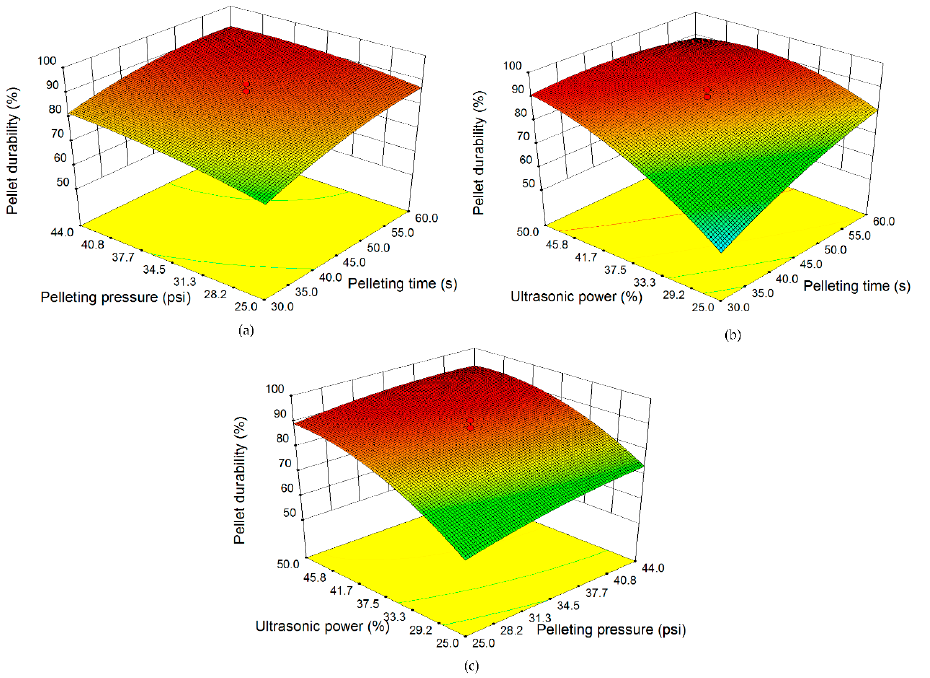
Figure 8. The interaction effects of pelleting time, pelleting pressure, and ultrasonic power on pellet durability. ( a ) The pellet durability in relation to pelleting time and pressure in a three-dimensional response surface. Pelleting pressure ranged from 25 psi to 44 psi and pelleting time ranged from 30 s to 60 s, respectively. ( b ) The pellet durability in relation to pelleting time and ultrasonic power in a three-dimensional response surface. Ultrasonic power ranged from 25% to 50% and pelleting time ranged from 30 s to 60 s, respectively. ( c ) The pellet durability in relation to pelleting pressure and ultrasonic power in a three-dimensional response surface. Ultrasonic power ranged from 25% to 50% and pelleting pressure ranged from 25 psi to 44 psi, respectively.